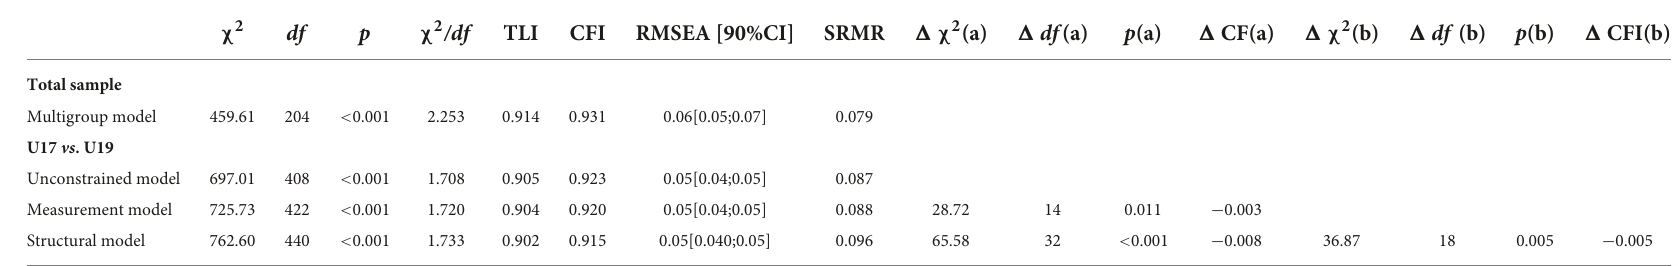
TABLE 4 Comparative summary of fit indexes and multigroup invariance tests based on competitive